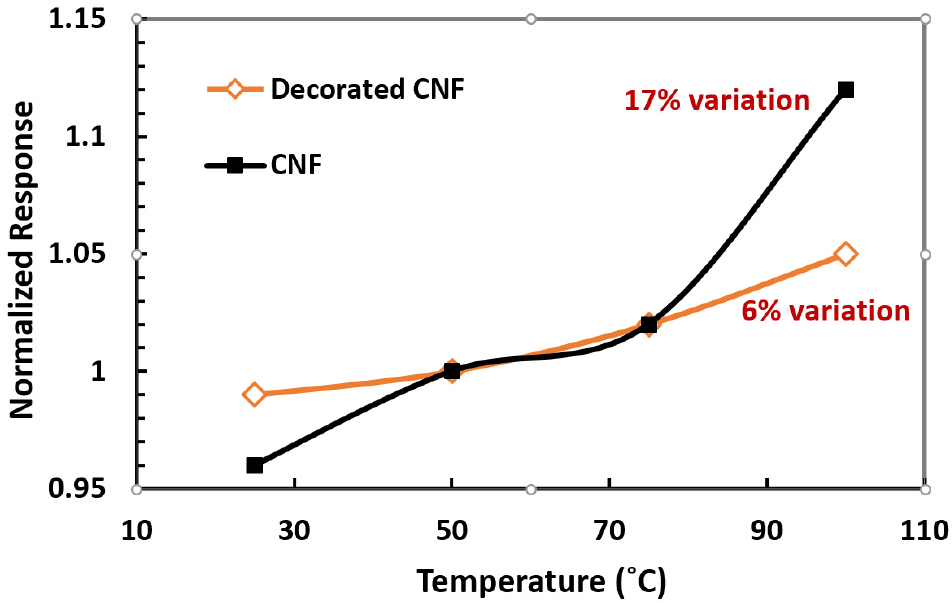
Figure 11. Variations in response levels of CNF and decorated CNF samples by changing operation temperature range at the presence of saturated concentration of ethanol vapor.